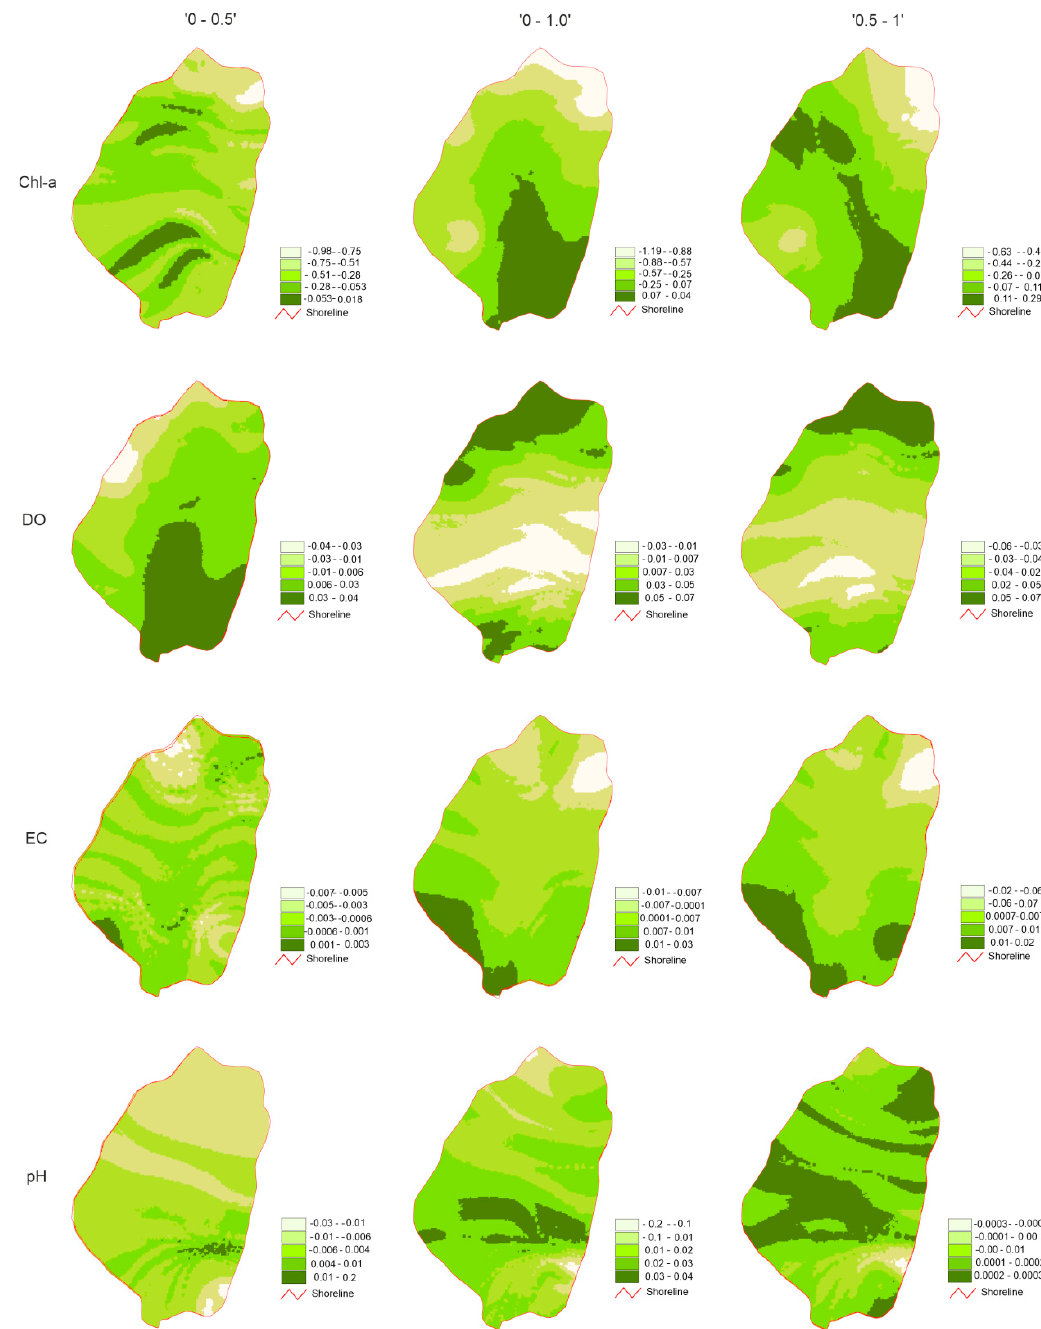
Figure 2. Partial differential maps calculated with TB and NN methods: “0–0.5”, “0–1”, “0.5–1”.